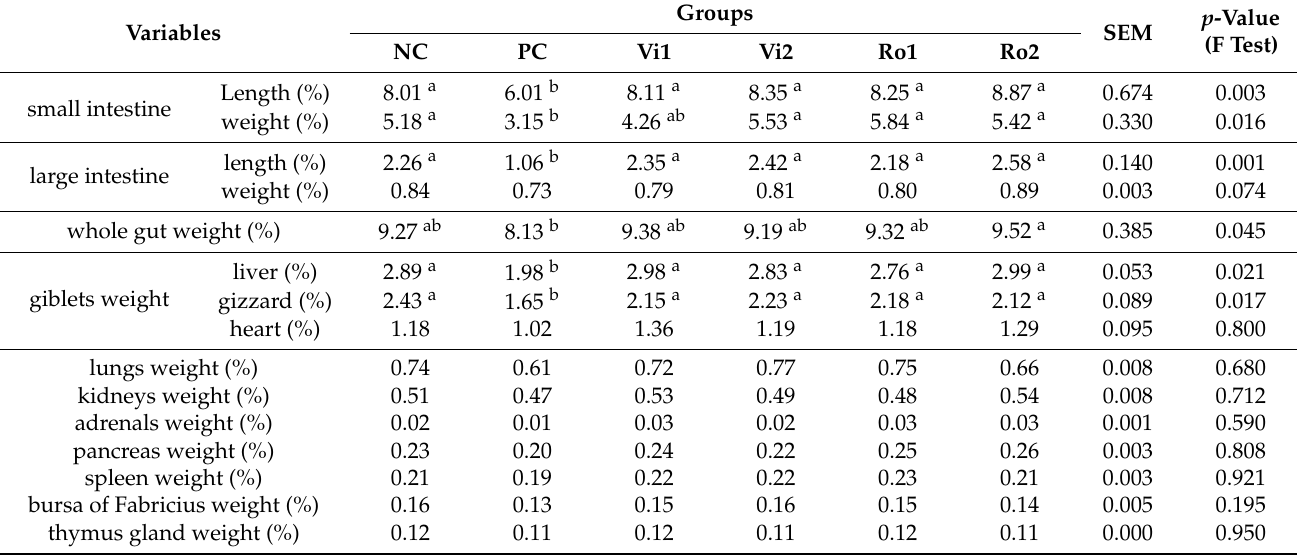
Table 6. Visceral organs’ relative weight and length (as a proportion of total gastrointestinal tract weight or length, respectively) affected by dietary vinegar and rocket salad of stressed broiler chickens ( n = 16/treatment).